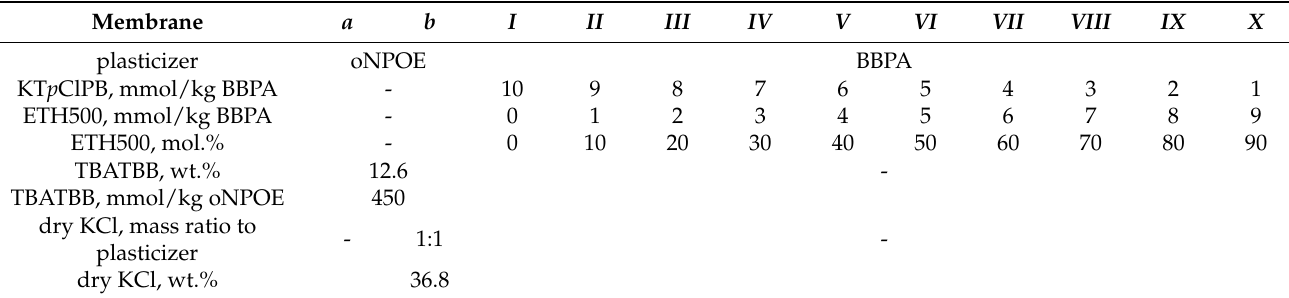
Table 1. Composition of the prepared electrode